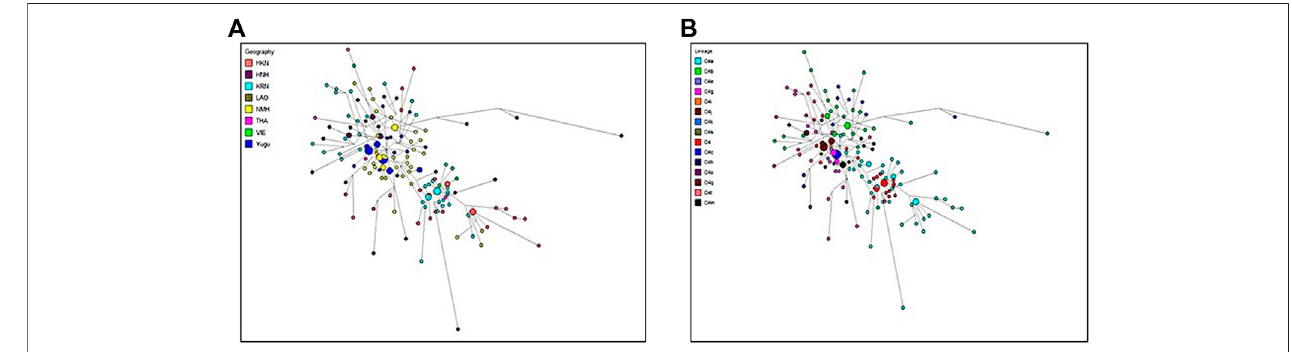
FIGURE 8 | The median networks of mitochondrial D4 haplogroup. (A) D4 haplogroup colored by the geographic origins of the populations; (B) D4 haplogroup colored by lineages of the populations. Different colors represent different continental origins or different haplogroup lineages, and the size of the circle is proportional to the number of individuals.